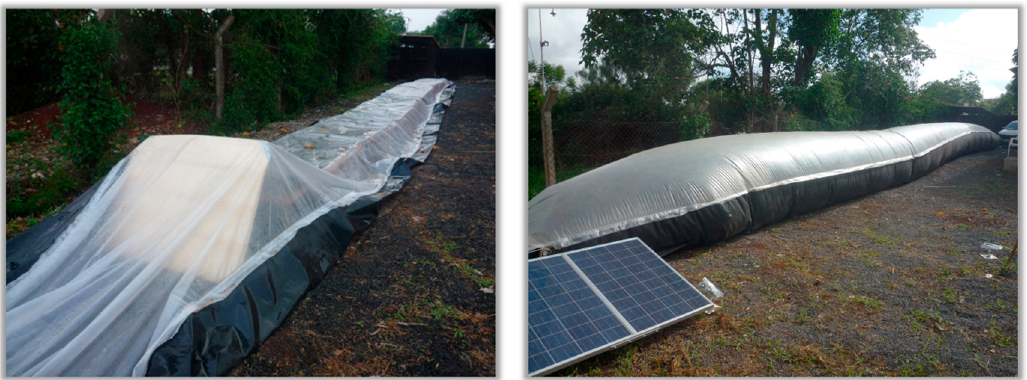
Figure 1. Inflatable solar dryer (ISD) before being inflated ( left , note the deflector board) and the inflated ISD during drying experiments ( right ).